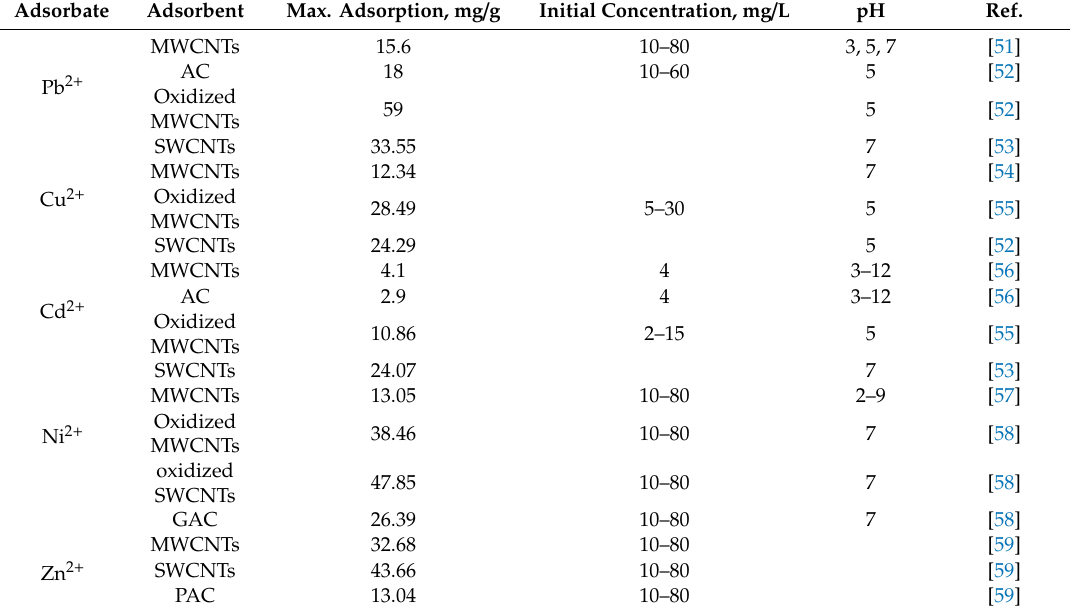
Table 3. The maximum adsorbents capacities for various carbon-based